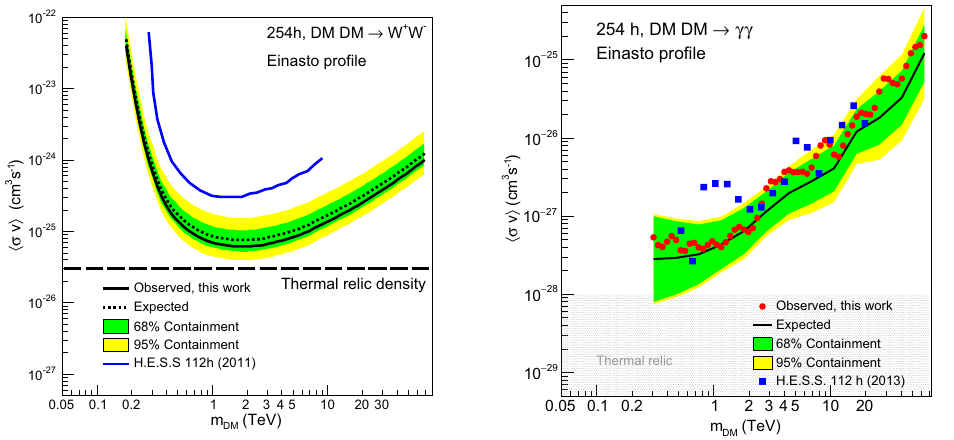
Figure 1. 95% C.L. upper limits on (cid:2) σv (cid:3) as function of the DM mass from H.E.S.S. observations of the GC region assuming an Einasto profile for the DM distribution on the GC. The limits are shown for the W + W − (left) and the prompt γγ (right) channels, respectively. In each case, the natural scale expected for (cid:2) σv (cid:3) is shown. The observed limits together with the expected limits and their associated 1 and 2 σ containment bands are plotted. Figures extracted from Ref. [4] and Ref. [5],